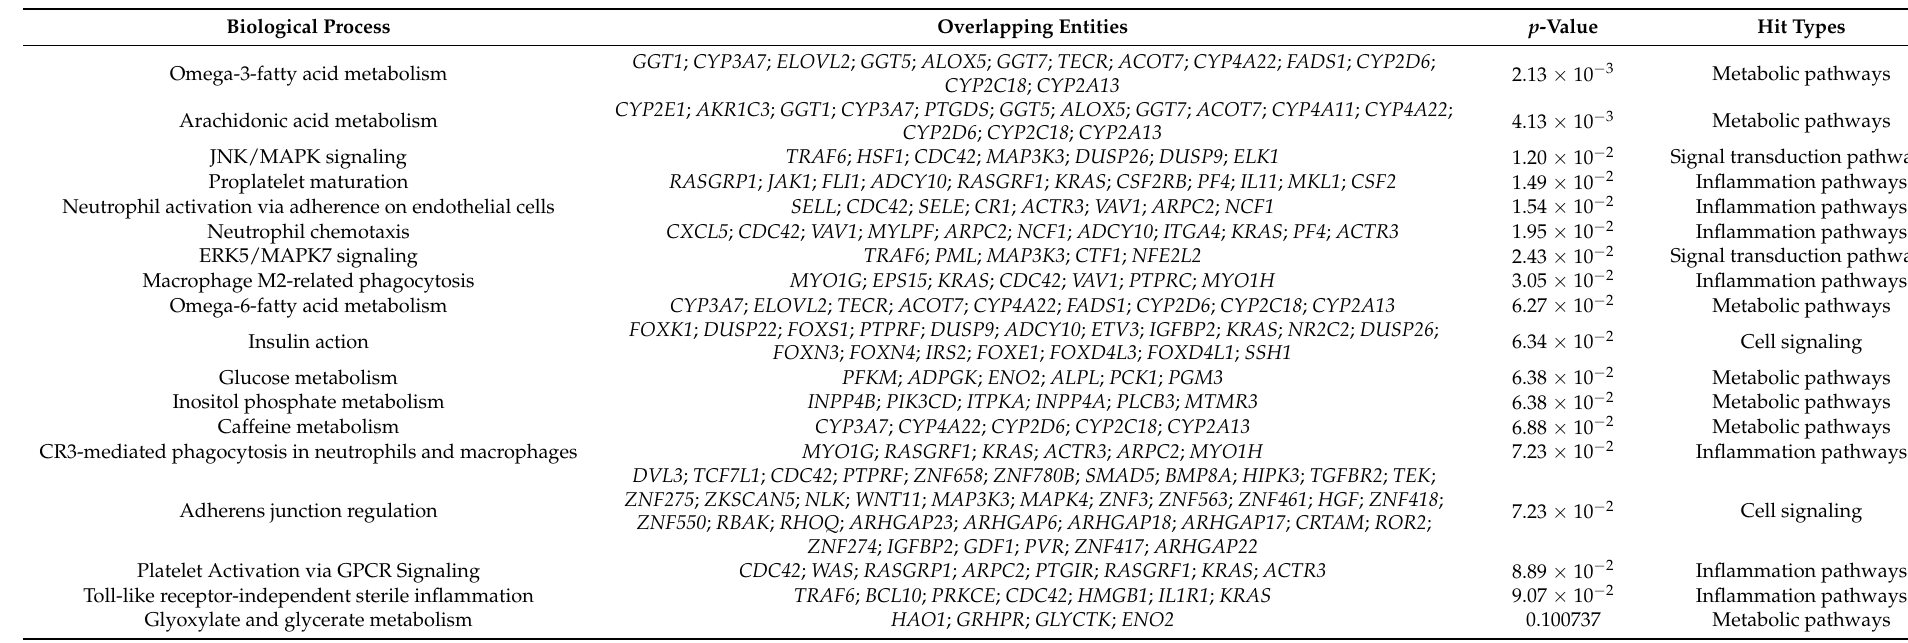
Table 7. A list of statistically significant biological processes in age group 60 as compared to age group 30 ( p < 0.05, FDR), sorted according to the p -value by Fisher’s exact